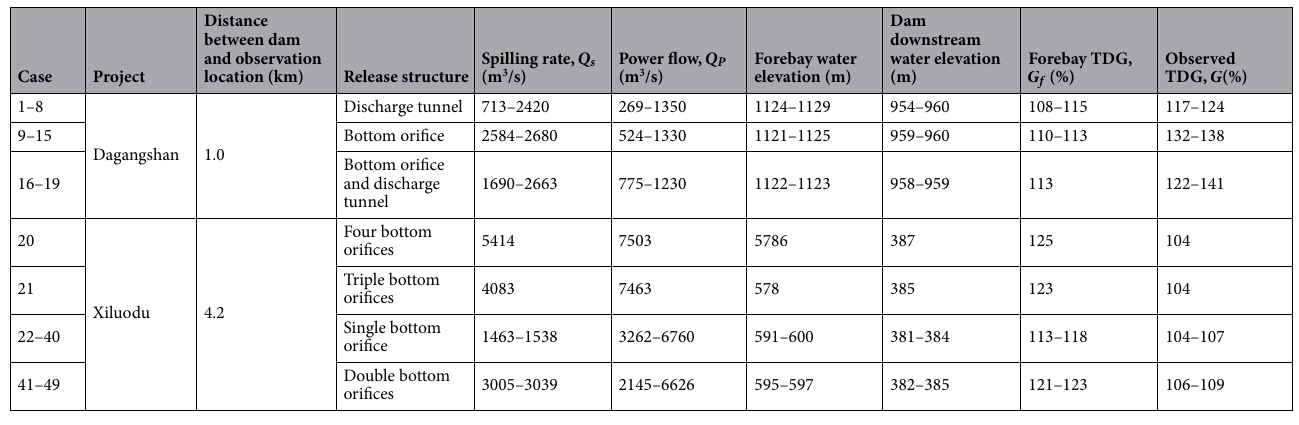
Table 1. TDG observations for the Dagangshan and Xiduodu